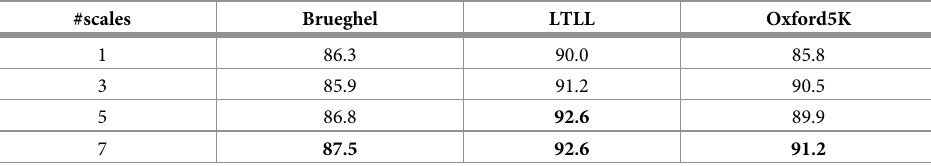
Table 3. Effect of the multi-scale region-of-interest pooling.